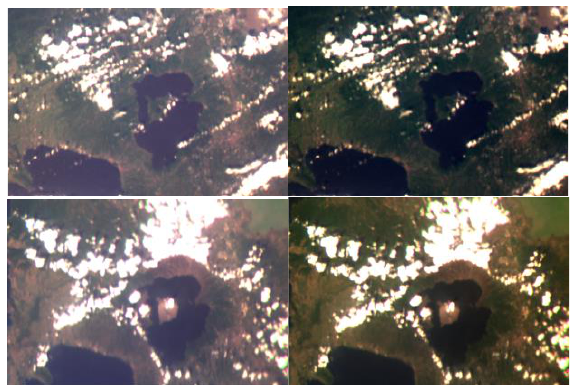
Figure 2. January 6 (top) and January 27 (bottom) Diwata-2 images before (left) and after (right) atmospheric correction